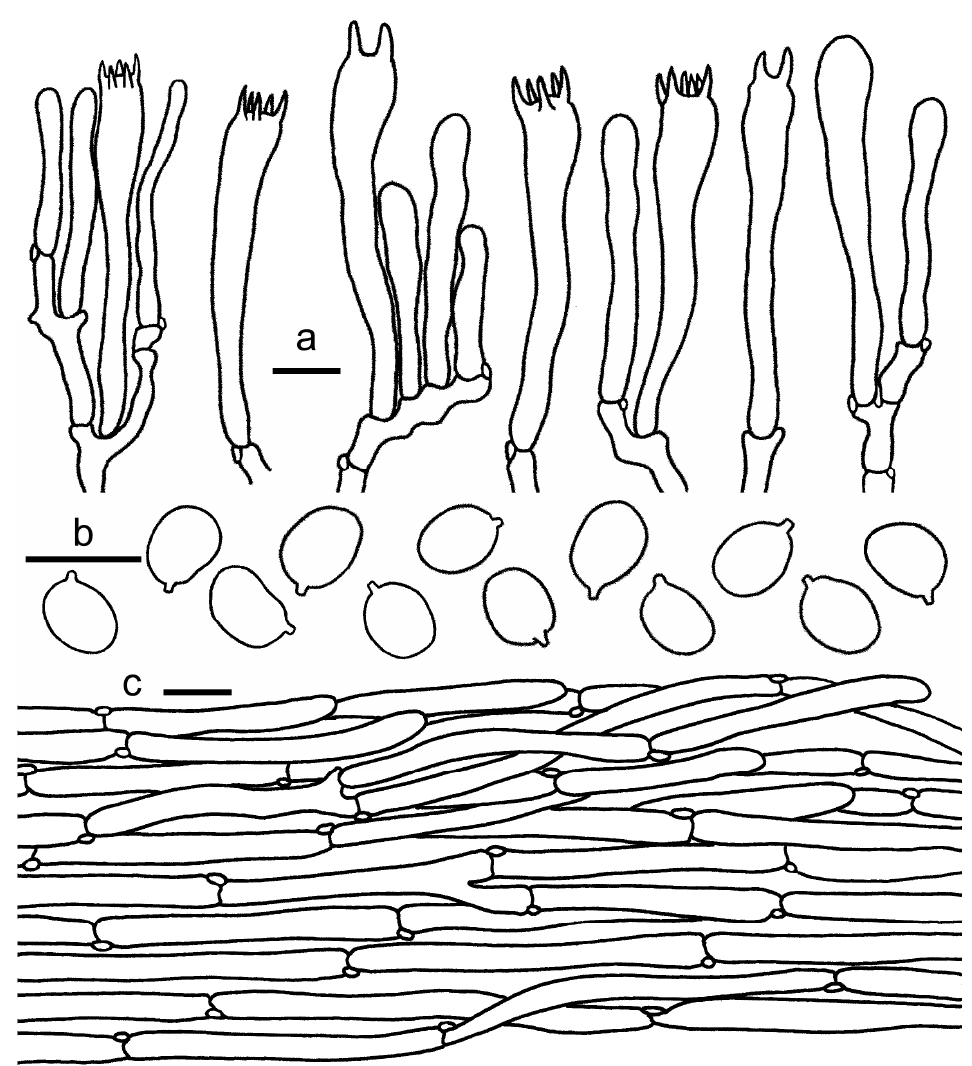
Figure 7. Cantharellus albovenosus . ( a ) Basidia, basidiola and elements of the subhymenium. ( b ) Ba- sidiospores. ( c ) Pileipellis. Bars: ( a , b ) = 10 μ m; ( c ) = 20 μ m. iospores. ( c ) Pileipellis. Bars: ( a , b ) = 10 µ m; ( c ) = 20 µ